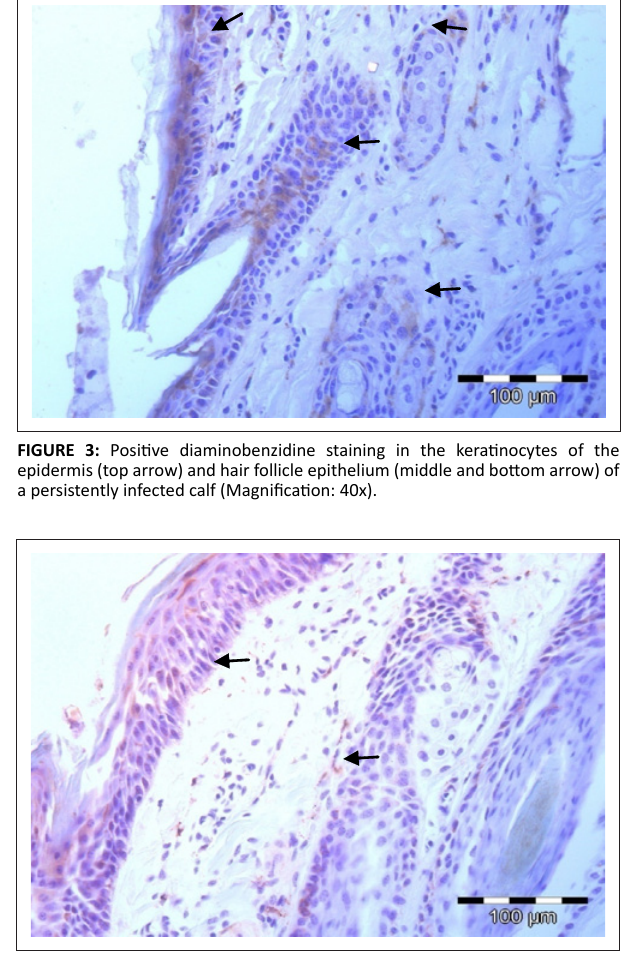
FIGURE 6: Positive NovaRED staining of hair follicle epithelium (arrows) in a persistently infected calf (Magnification: